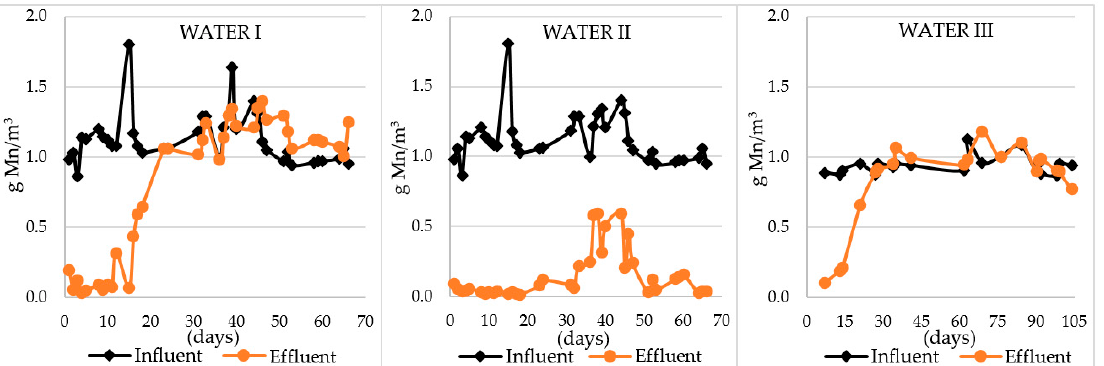
Figure 5. Change in the content of manganese compounds after biofiltration on the chalcedonite bed in the analyzed systems.